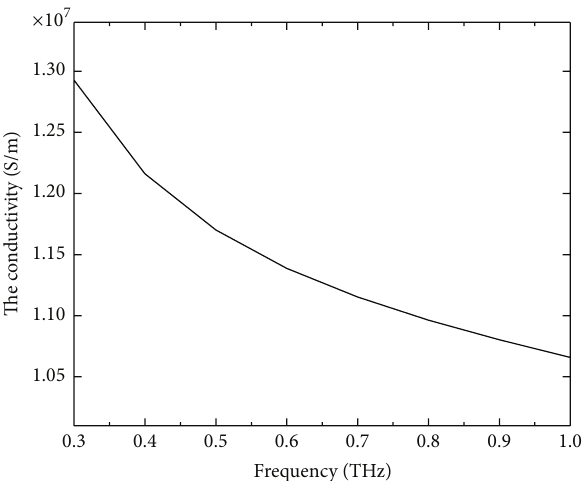
Figure 3: The conductivity of the gold thin film with surface roughness of 0.2 𝜇 m at the 300 ∼ 1000 GHz frequency band.